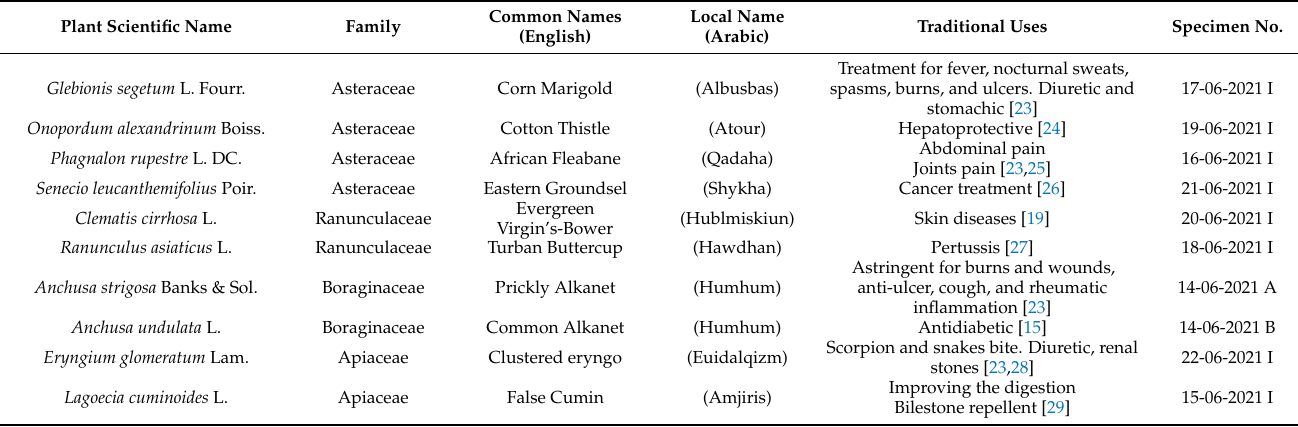
Table 2. A list of the plant species evaluated in this study, names and traditional